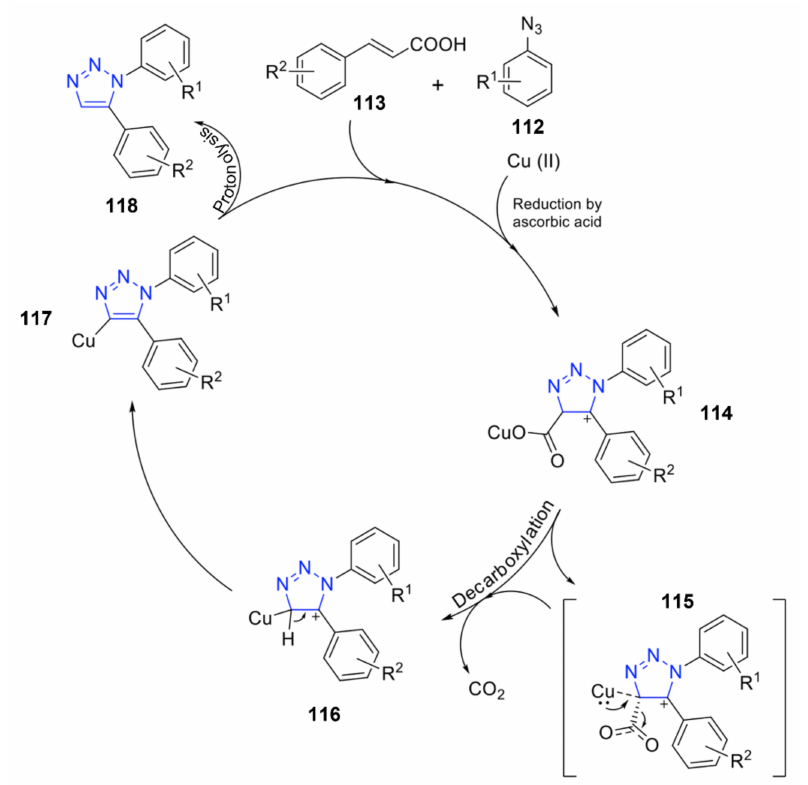
Scheme 37. Catalytic cycle for the Cu (I)-catalyzed synthesis of 1,5-disubstituted 1,2,3-triazoles 118 proposed by Kumar et